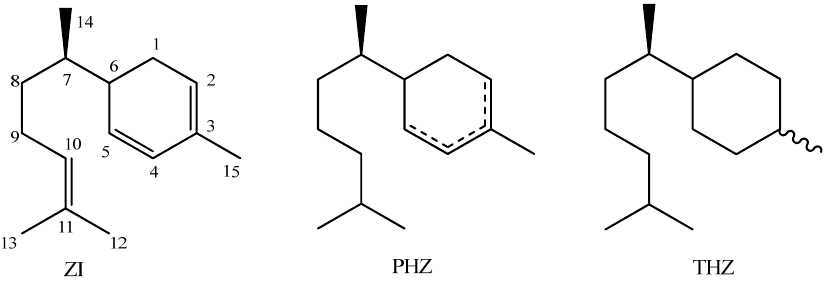
Figure 1. Structures of α -zingiberene (ZI), partially hydrogenated zingiberene (PHZ) and totally hydrogenated z ingiberene